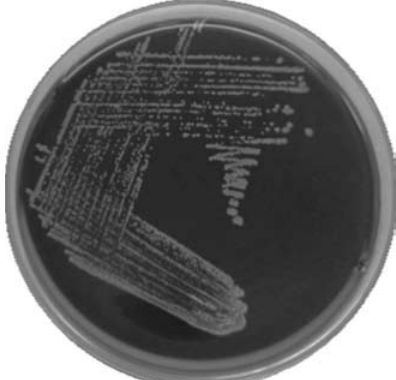
Fig.1. Greyish, round, spreading type, shiny, moistened colonies of Campylobacter spp. on P- mccD